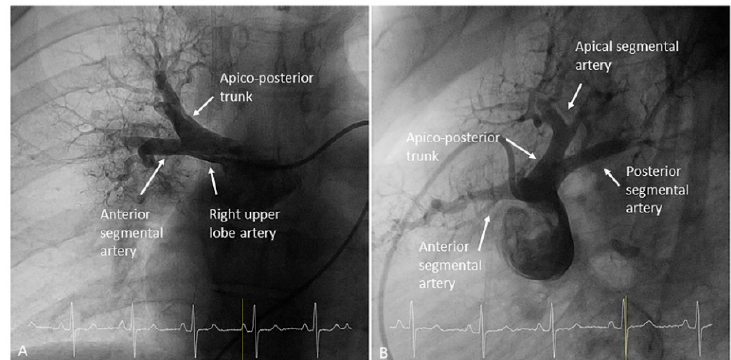
Figure 4. Right upper lobe arteries: apico-posterior trunk (A1/2) and anterior segmental branch (A3). ( A ) Anteroposterior view and ( B ) lateral view.